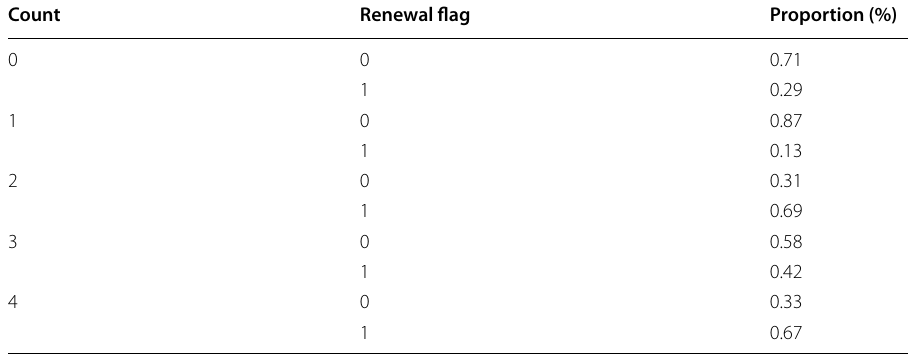
Table 5 Results of comparative analysis by renewal (Y/N)—call type 096